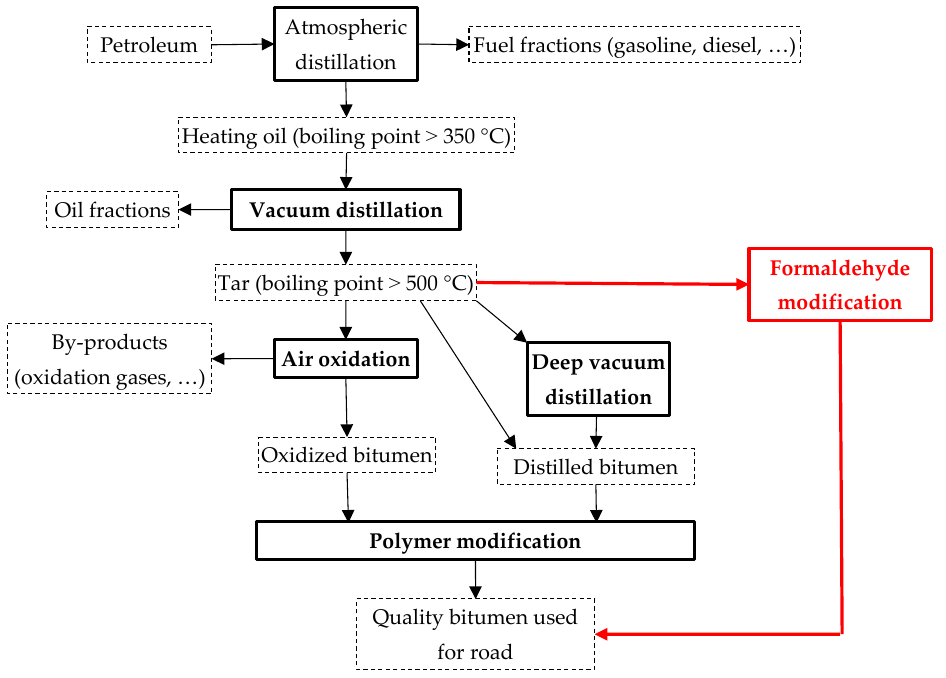
Figure 1. Scheme of bitumen production .